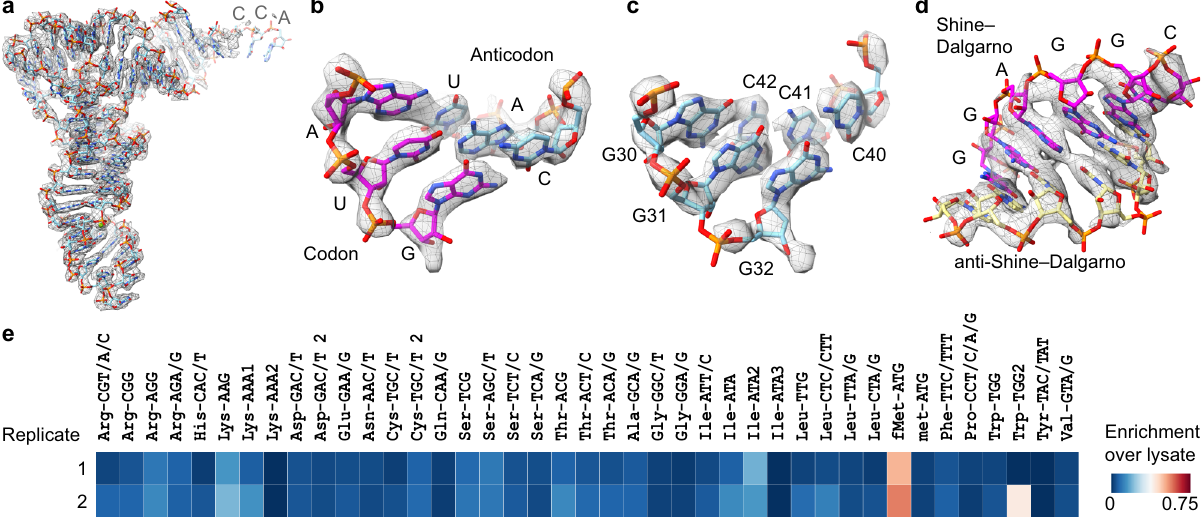
Fig. 2 The LsaA-70S complex contains an initiator tRNA and SD-helix. a – d Isolated density (grey mesh) with molecular models (sticks) for a initiator tRNA fMet (cyan), b interaction between AUG start codon of the mRNA (magenta) and anticodon of initiator tRNA fMet (cyan) in the P-site, c three G – C base pairs speci fi c to the initiator tRNA fMet (cyan) and d helix formed between Shine-Dalgarno (SD) sequence of the mRNA (magenta) and anti-SD of the 16S rRNA (yellow). e Replicate tRNA microarray analysis of the LsaA-70S complex, illustrating the enrichment of initiator tRNA fMet in the LsaA-70S complex over the lysate. Con fi dence intervals between replicates were